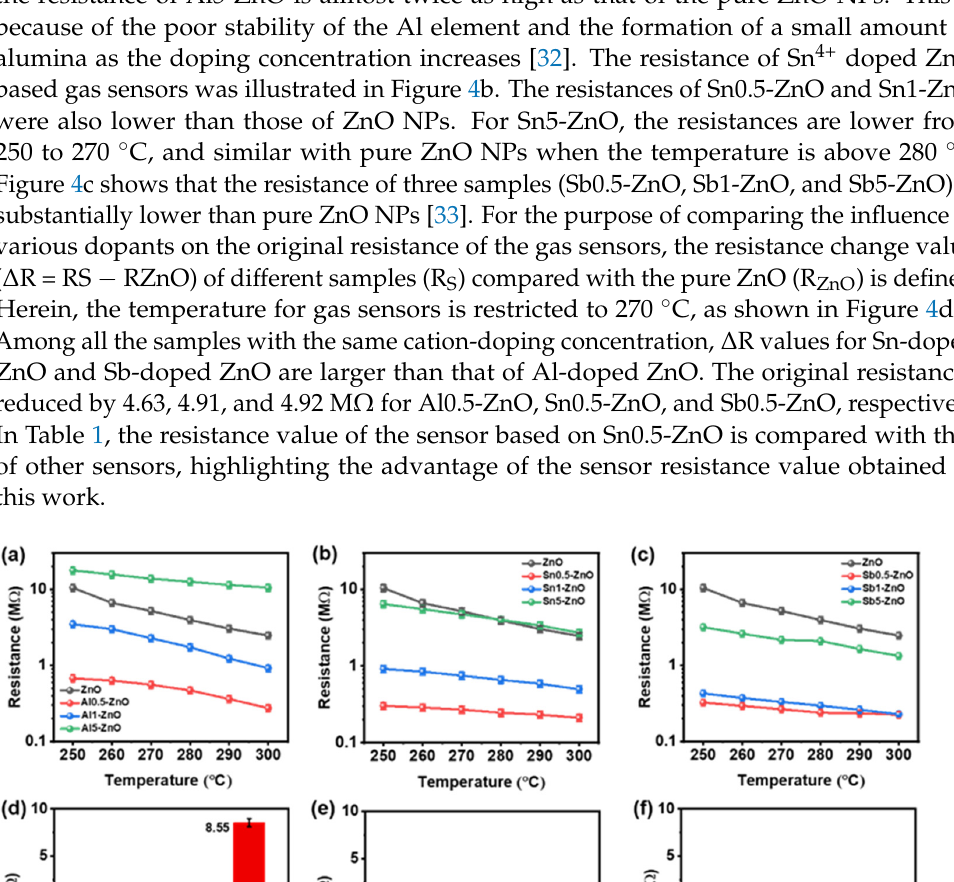
tures (250–300 ◦ C). ( d – f ) ∆ R = RS − RZnO (R S is indicated as the resistances of Al0.5-ZnO,